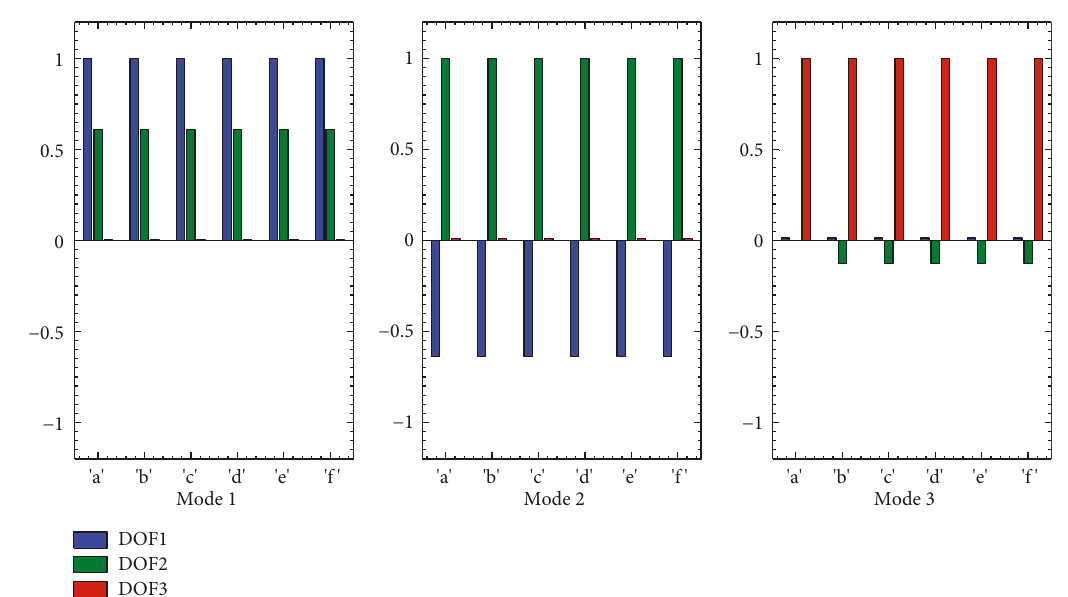
Figure 7: Modal shapes of the